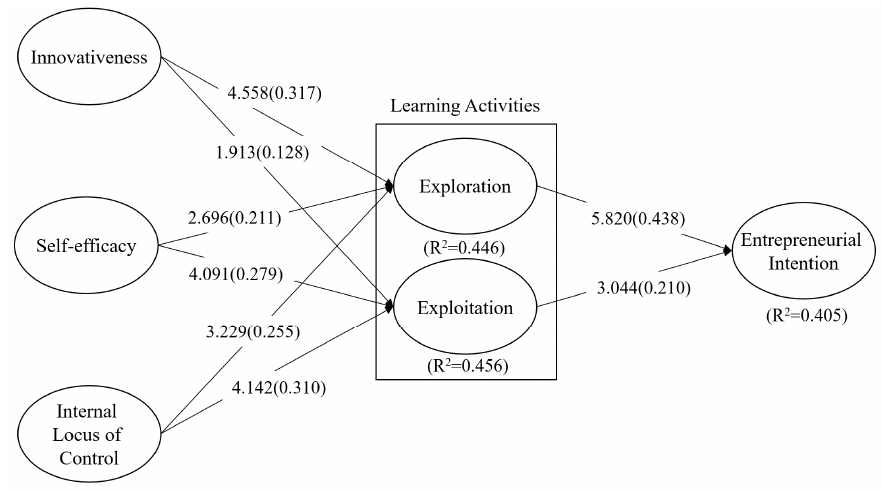
Figure 2. Results of the research model.